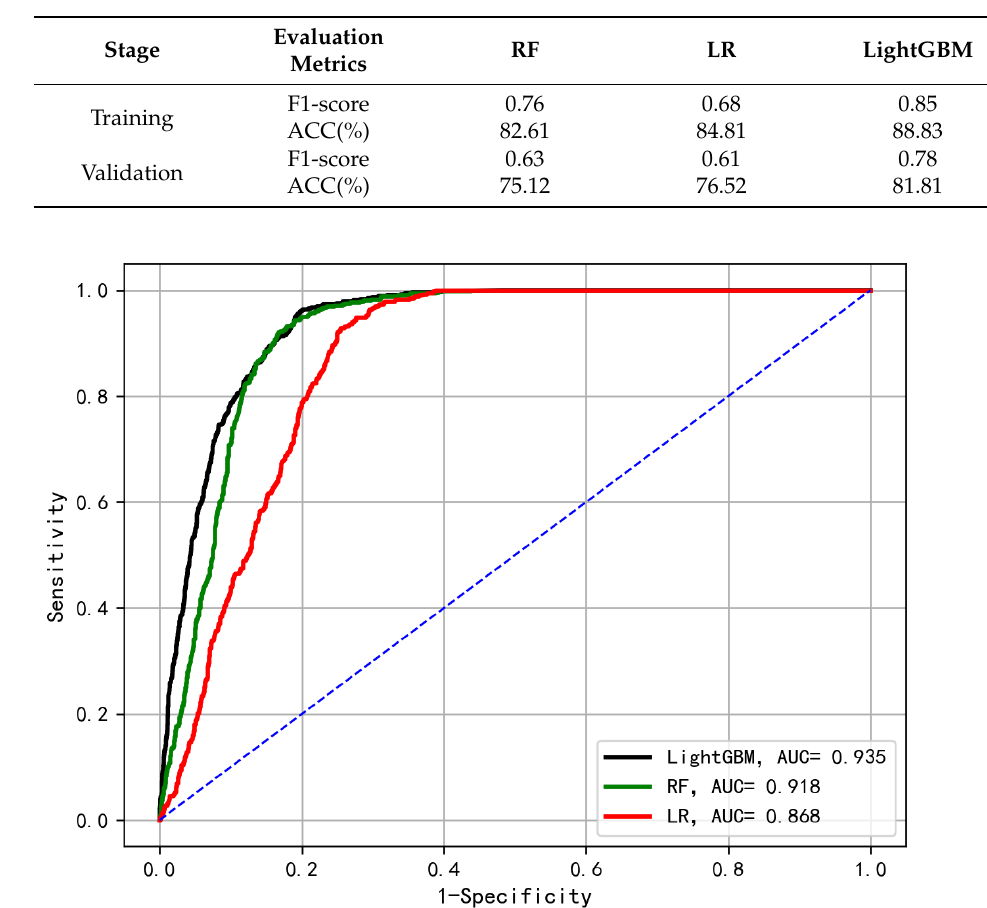
Figure 7. The ROC curves of the three